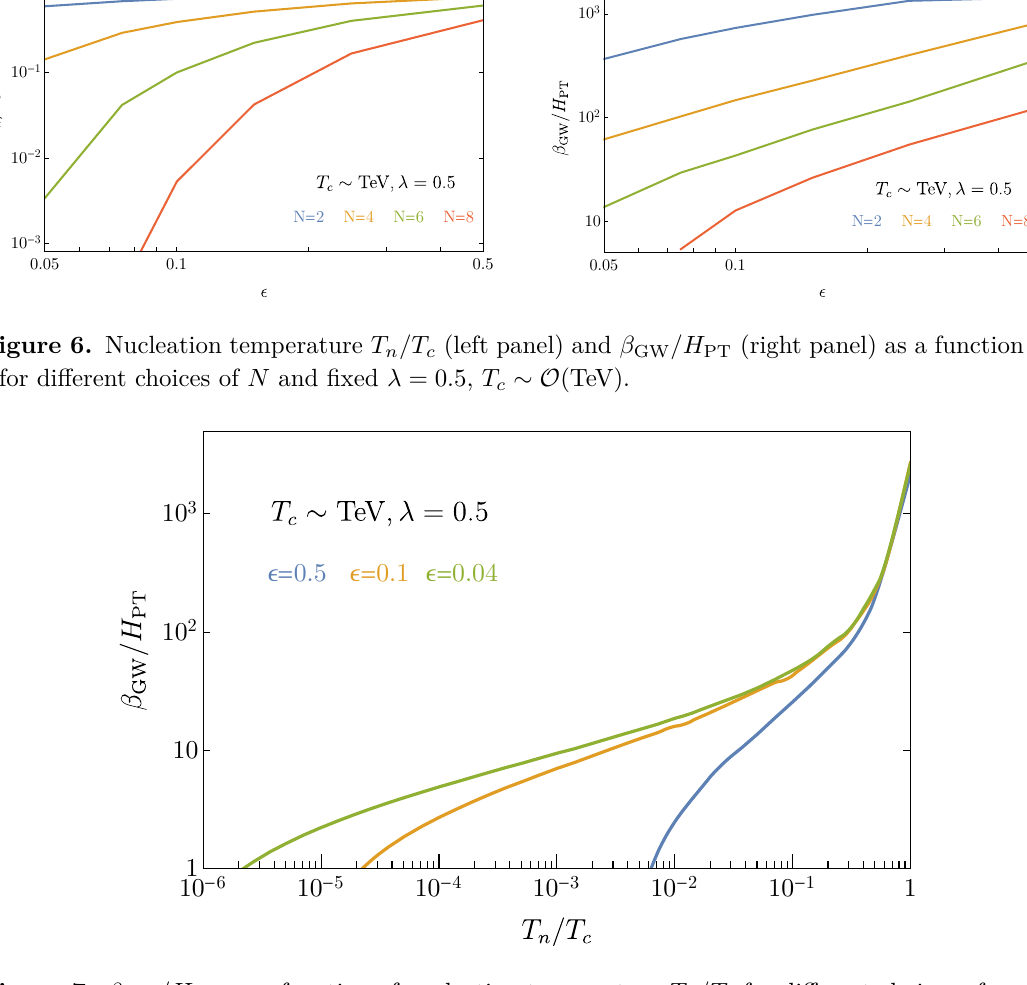
Figure 7. β GW /H PT as a function of nucleation temperature T n /T c for different choices of (cid:15) and fixed λ = 0 . 5 , T c ∼ O ( TeV ) . On each curve, N is varied while (cid:15) and λ are held